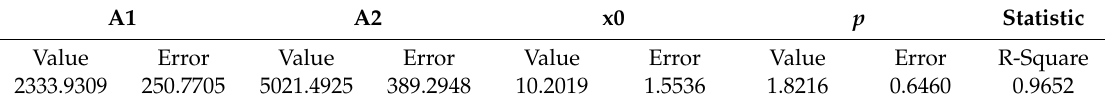
Table 4. The summary of the results of logistic fitting of the sakura region.